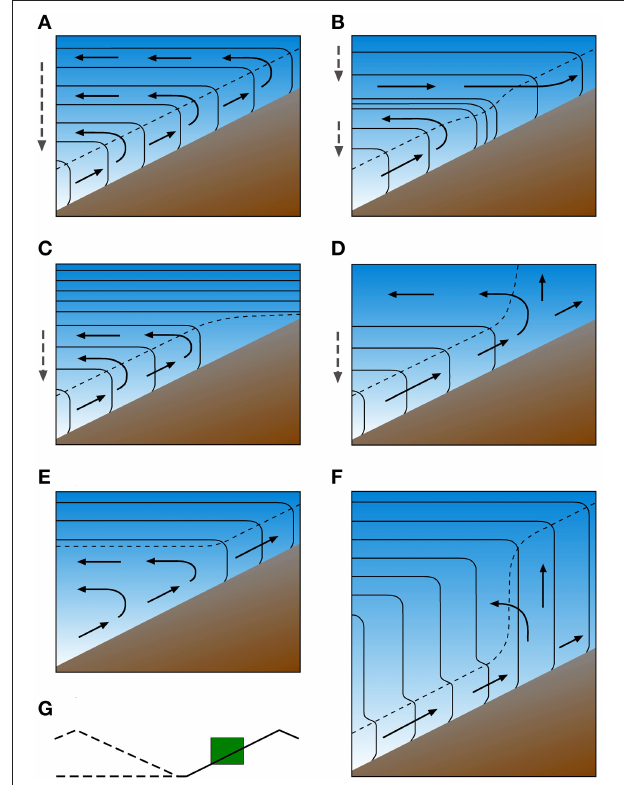
FIGURE 4 | Conceptual models of slope wind circulation and CBL structure over a slope on a fair weather day. The green box in (G) on the lower left shows the location of the depicted cross section over a slope facing a valley or a plain. Thin solid and dashed lines represent isentropes and the top of the turbulent CBL, respectively. Solid and dashed arrows indicate the airflow and the compensating subsidence over the valley center or over the plain. (A) Slope wind circulation with homogeneously stratified atmosphere over the valley center or plain. (B) Two staggered slope wind circulations separated by a strongly stratified layer. (C) Slope wind circulation limited to lower slope due to strongly stratified layer aloft. (D) Slope wind venting into neutrally stratified layer aloft. (E) Recirculation of slope winds within the turbulent CBL. (F) Jump in CBL depth due to erosion of the inversion above the upslope wind layer and a deep neutrally stratified layer